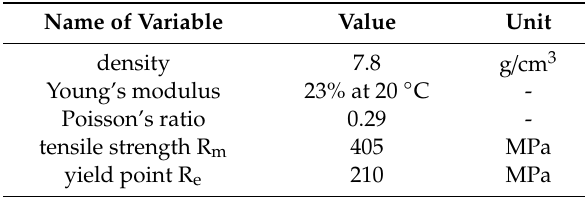
Table 1. Mechanical and strength properties of the guide rail